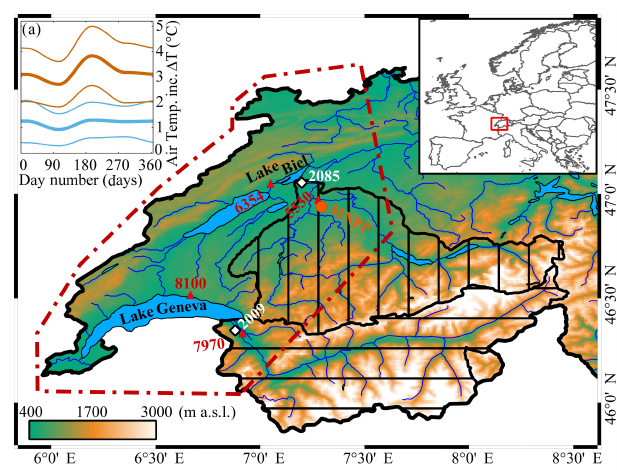
Figure 2. Study area and predicted regional air temperature in- creases. Elevation above sea level (green to white color ramp), lo- cations and number of river stations (white diamonds) and atmo- spheric monitoring stations (red triangles), drainage area (Aare: ver- tical lines; Rhône: horizontal lines) and location of Mühleberg Nu- clear Power Plant (MNPP, orange circle). Area covered by regional climate models (dark red dashed-dotted line) with (a) predicted air temperature increase (cid:49)T in the near-future (blue, 2030–2049) and far-future (orange, 2080–2099) for medium (thick lines) and up- per/lower estimates (thin lines) under the A1B emission scenario (CH2011,